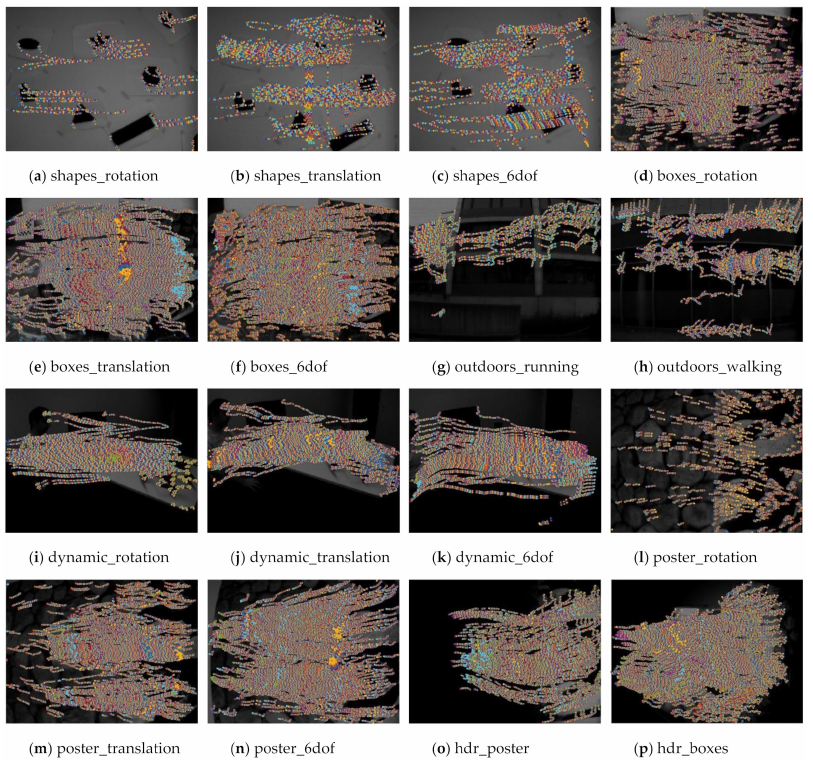
Figure 6. Illustration of feature tracking solutions from WF-MHT-BP (Each subgraph show the trajectories of tracked features projected on the first intensity